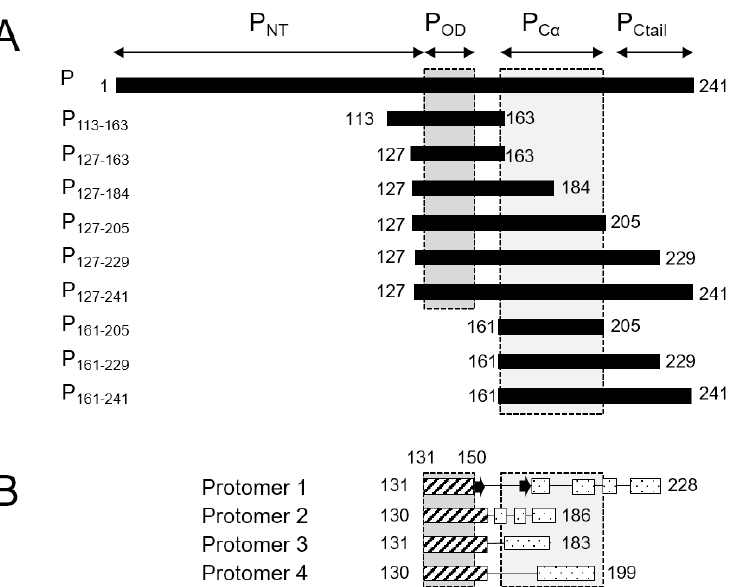
Figure 1. Schematic representation of RSV phosphoprotein (P) domains and fragments. ( A ) Boundaries of the N-terminal domain, oligomerization domain, C-terminal α -helical domain and C-terminal tail of the RSV P protein and definitions of the RSV fragments used herein. ( B ) Topology ( α -helices and β -strands) of the visible parts of the four RSV P protomers in the cryo-EM structure of the RSV L—P complex (PDB 6PZK, [41] ).